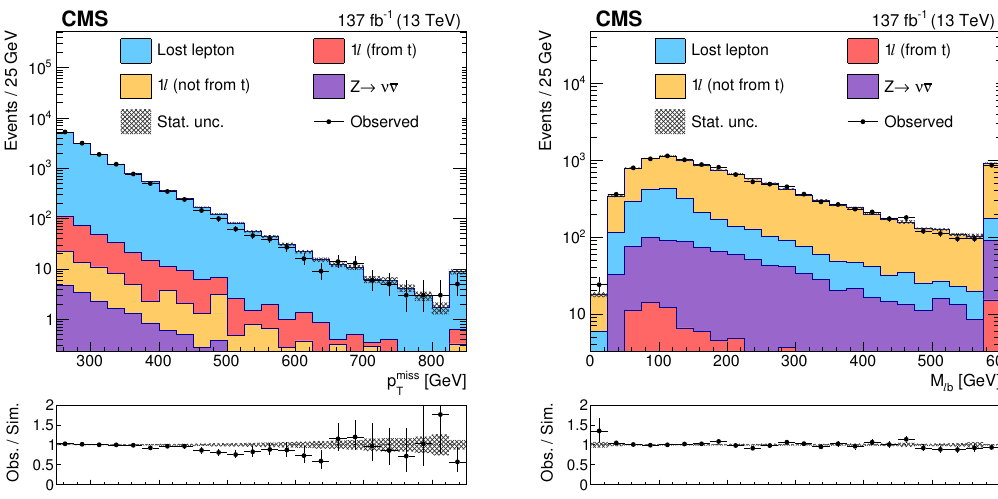
Figure 4 . Distributions of kinematic variables in the inclusive control samples used for the back- ground estimation. The gray hashed region indicates the statistical uncertainty of the simulated samples. The distributions for data are shown as points with error bars corresponding to the sta- tistical uncertainty. The stacked histograms show the expected SM background contributions from simulation, normalized to the number of events observed in data. The last bin in each distribu- tion also includes the over(cid:13)ow. Left: distribution of p miss in the dilepton control sample. T